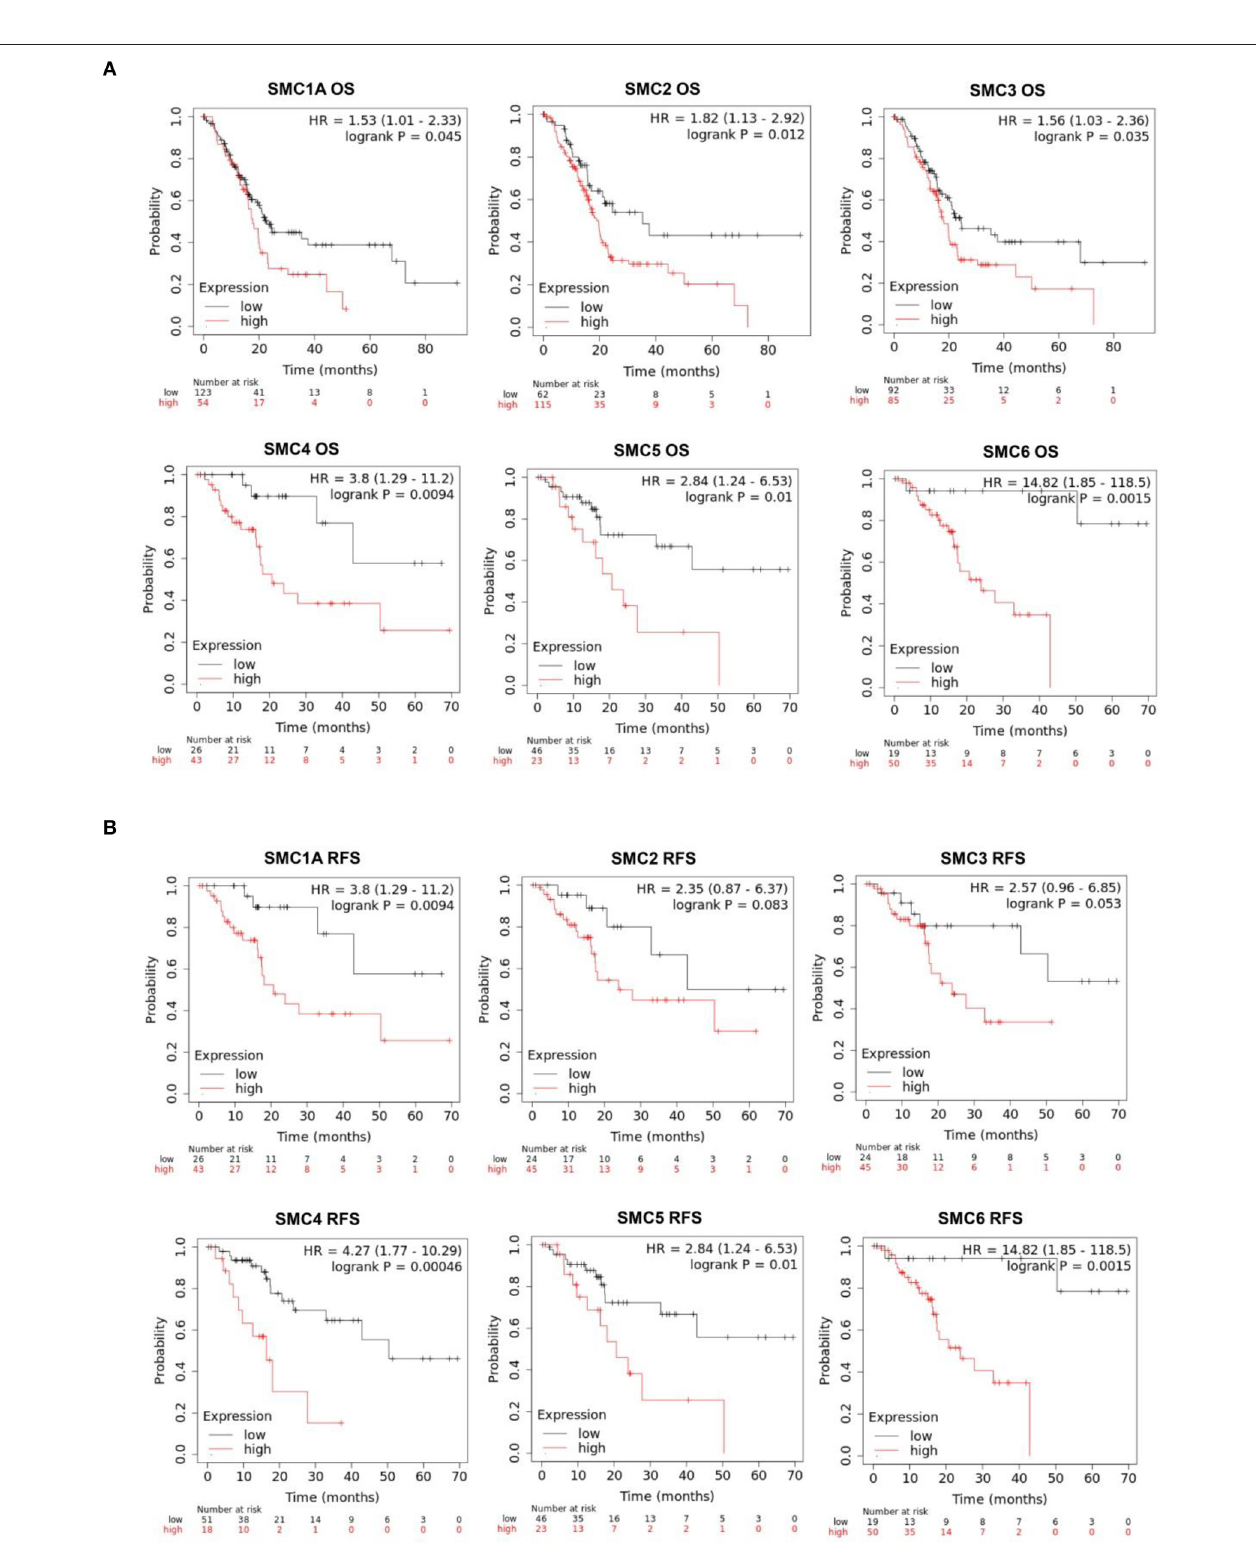
FIGURE 6 | Prognostic value of SMC family gene expression levels with regard to the survival of PAAD patients. Relationships between SMC family gene expression levels and (A) overall survival (OS) and (B) recurrence-free survival (RFS) of PAAD patients, as estimated using Kaplan–Meier plotter.